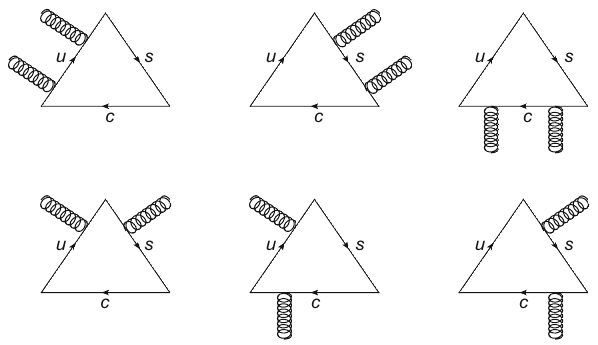
Fig. 3 Thequark–quark(QQ)plusquark–gluon(QG)condensatecon- tributions (solid line) and also gluon–gluon (GG) condensate (dash-dot line) on Q 2 for the off-shell D meson